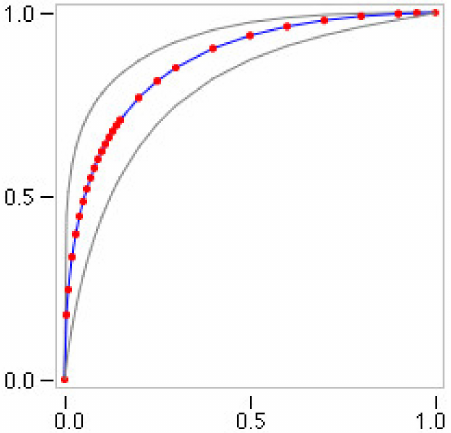
Figure 7. The ROC area of all the final adjusted trained data: AUC (0.867).